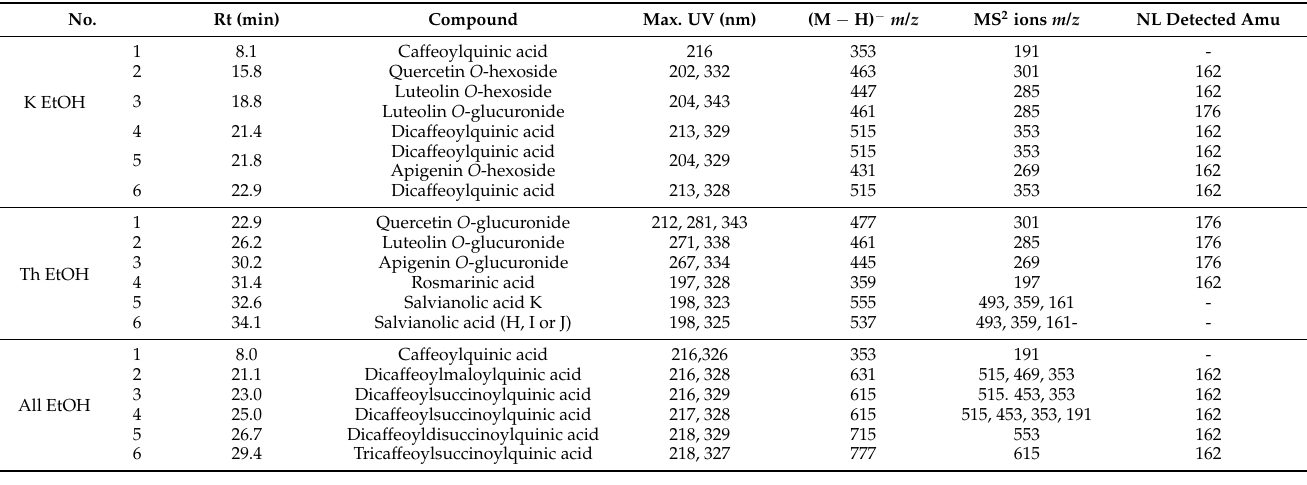
Table 4. The MS2 data of compounds detected in Millefolii herba ethanolic extract (K EtOH), Serpylli herba ethanolic extract (Th EtOH), and Arctii lappae folium ethanolic extract (All EtOH). NL—neutral loss detected corresponding to the cleavage of sugar or phenolic acid.